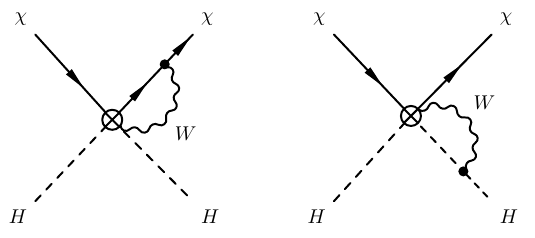
; : : : ; Q (6) operators at one loop. 15 18